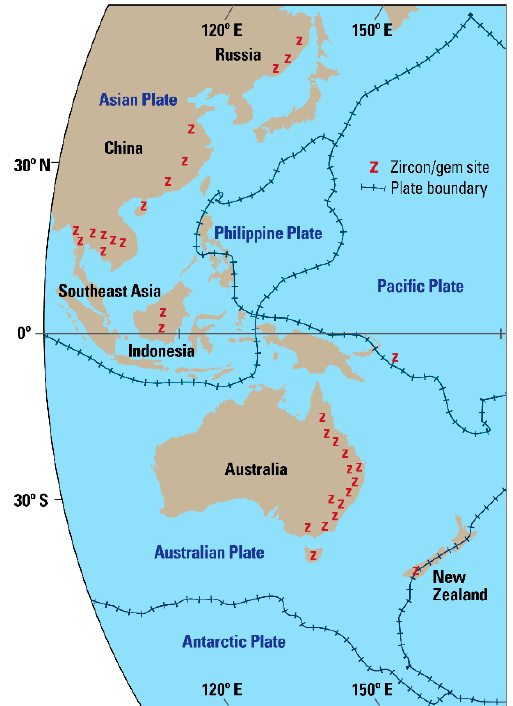
Figure 1. Map showing the 12,000 km long zircon megacryst Indo-Pacific zone (ZIP) along the western Pacific continental margins in Eastern Australasia, Asia, and Russia. The intraplate basalts hosting the megacryst suites are dominantly alkaline in composition and involve deeper mantle generation of magmas that may intersect pre-existing gem-bearing felsic or metamorphic bodies [11]. Consult this reference for zircon locality details.